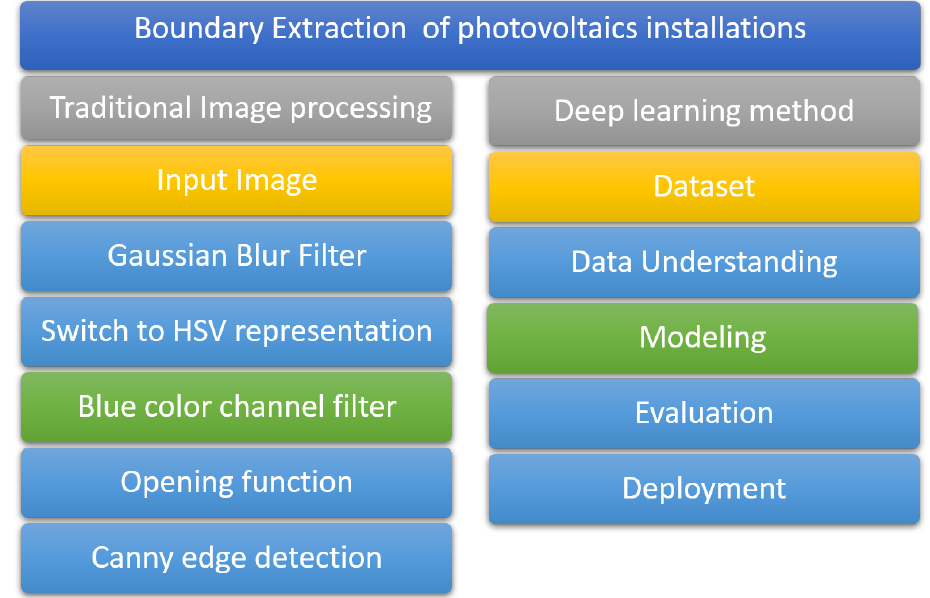
Figure 1. Steps of boundary extraction by image analysis with two